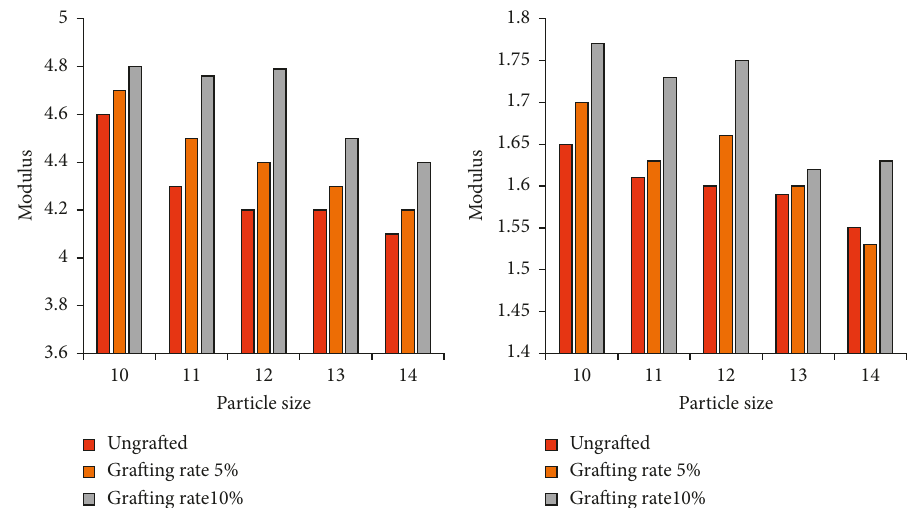
Figure 7: Schematic diagram of the relationship between composite material modulus and particle